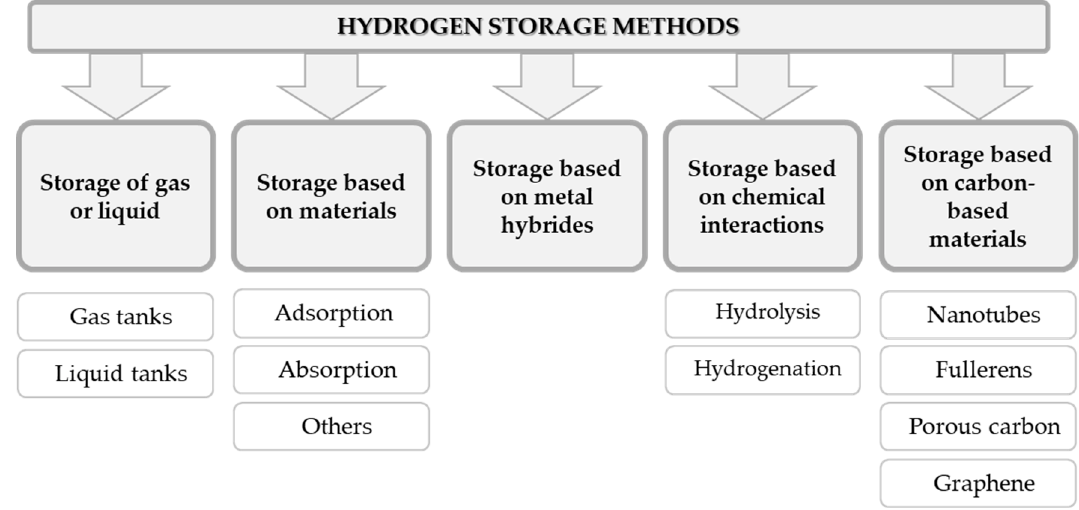
Figure 5. Summary of the most popular hydrogen storage methods [14].